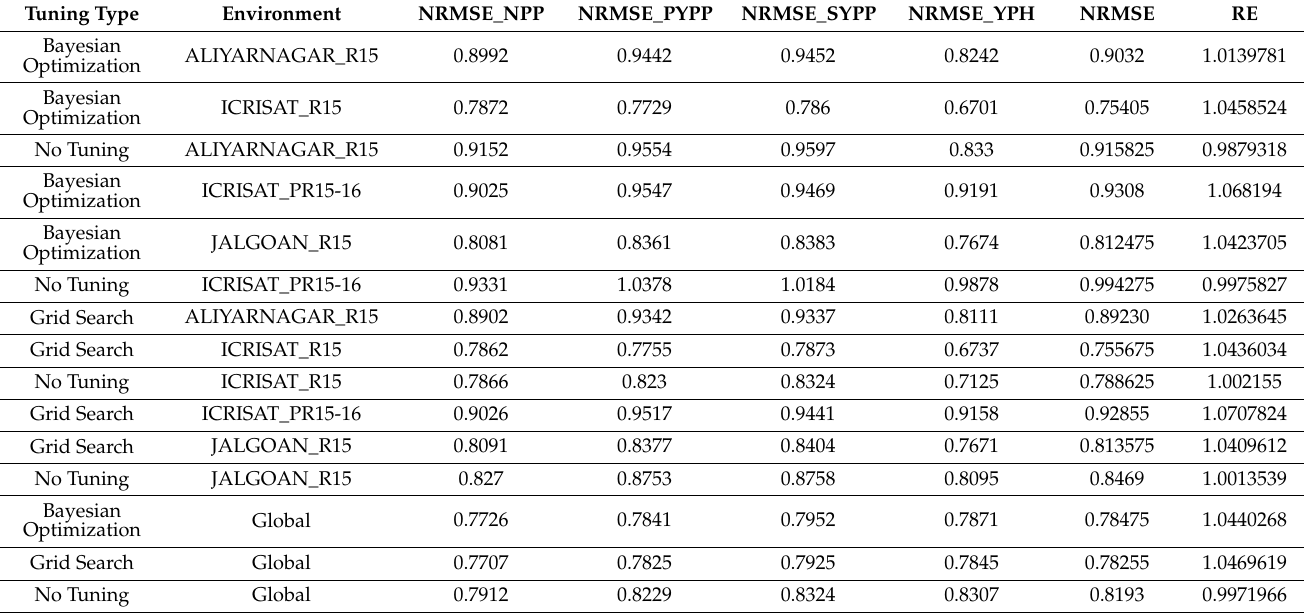
Table A3. The prediction performance for every environment and across environments (Global) of the dataset 3 (Groundnut) in terms of normalized root mean square error (NRMSE) under three tuning methods (BO, GrS and NT) for Groundnut dataset. RE denotes relative efficiency. The RE in rows corresponding to BO were computed dividing the NRMSE under NT by the NRMSE under BO. While the RE in rows corresponding to GrS were computed dividing the NRMSE under NT by the NRMSE under GrS. While those RE in the rows corresponding to NT strategy were computed dividing the NRMSE under GrS by the NRMSE under BO.